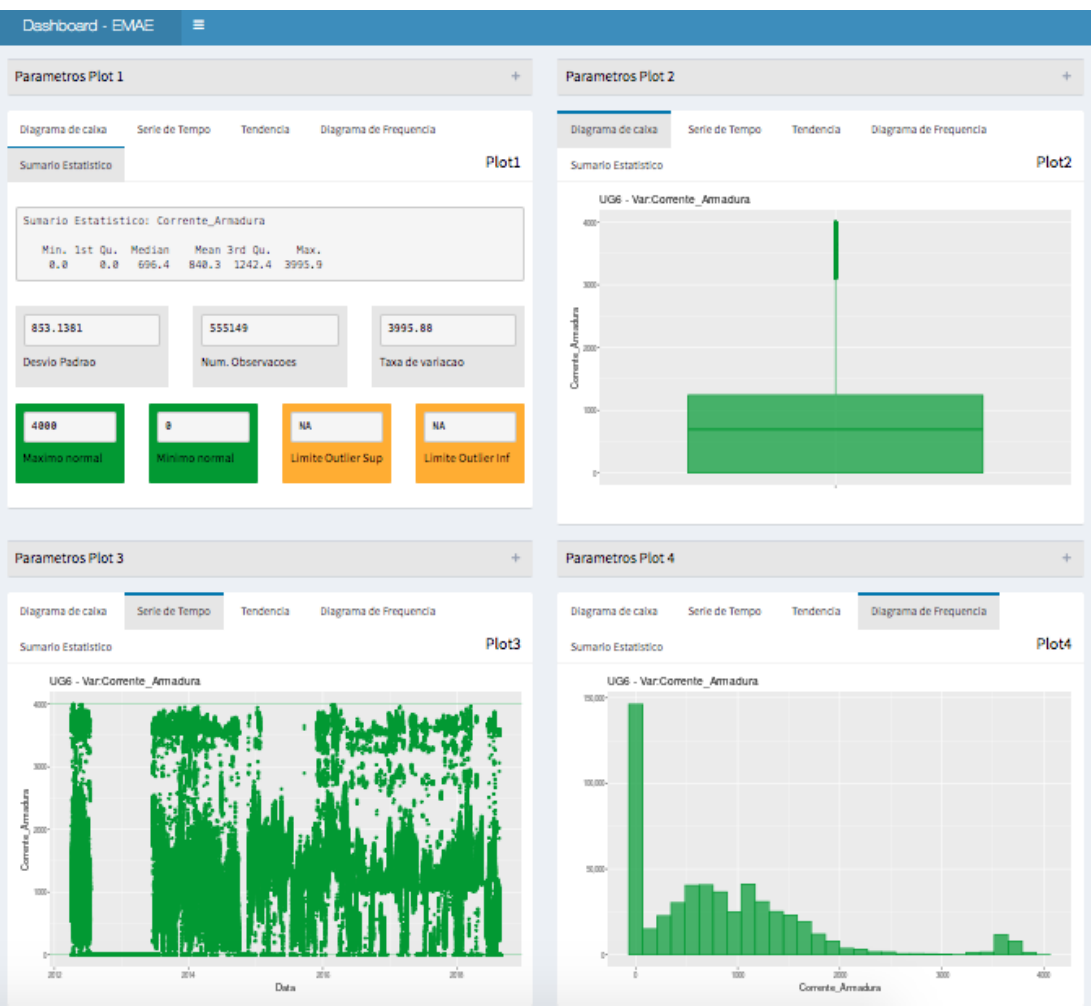
Figure 5. Variable “Armor Current”—Exploratory Analysis in the Analytical